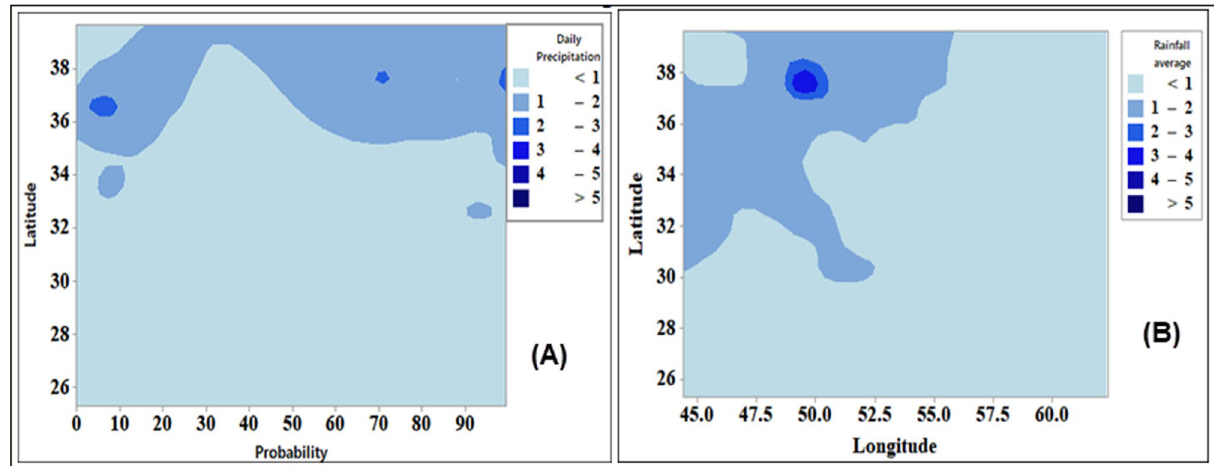
Fig. 12 Probability of the daily rainfall based on predicted data ( A ) and original data ( B ) in